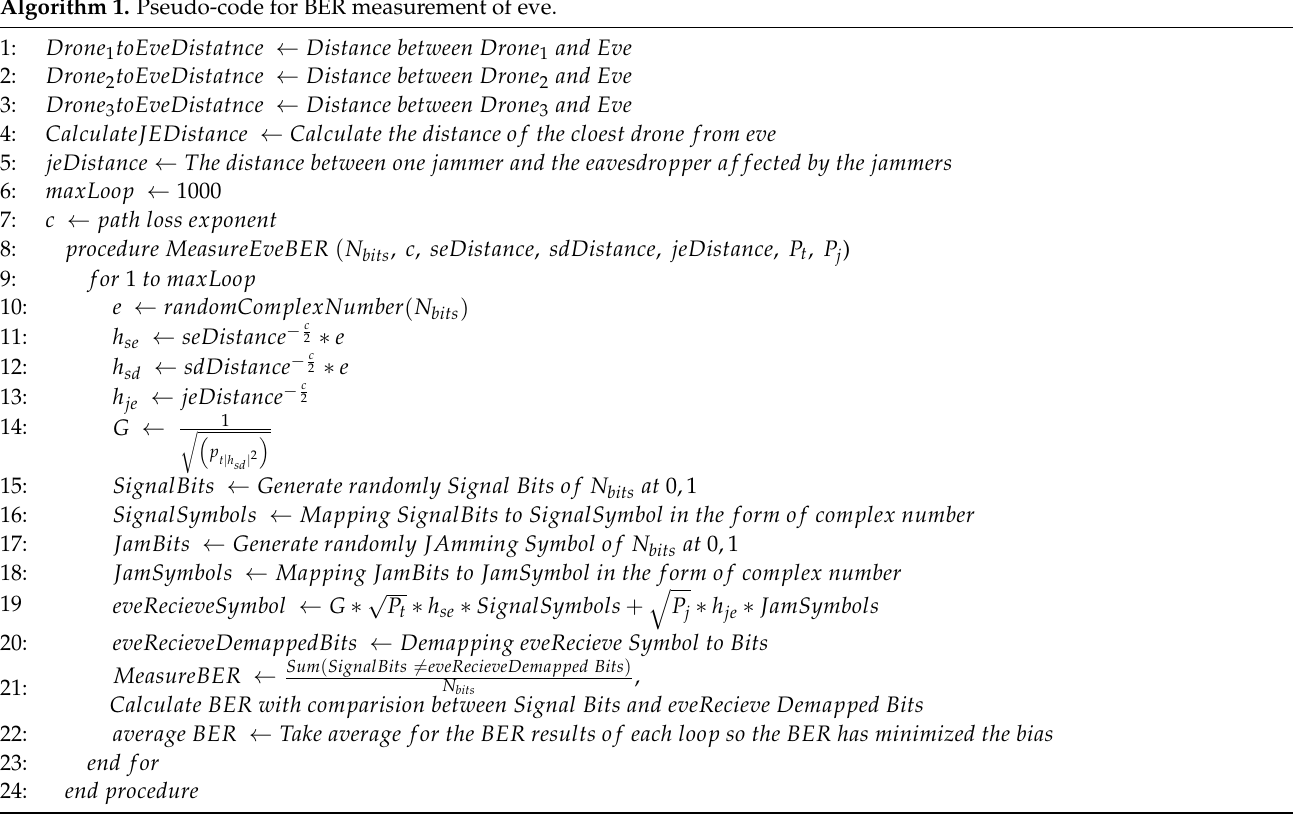
Algorithm 1. Pseudo-code for BER measurement of